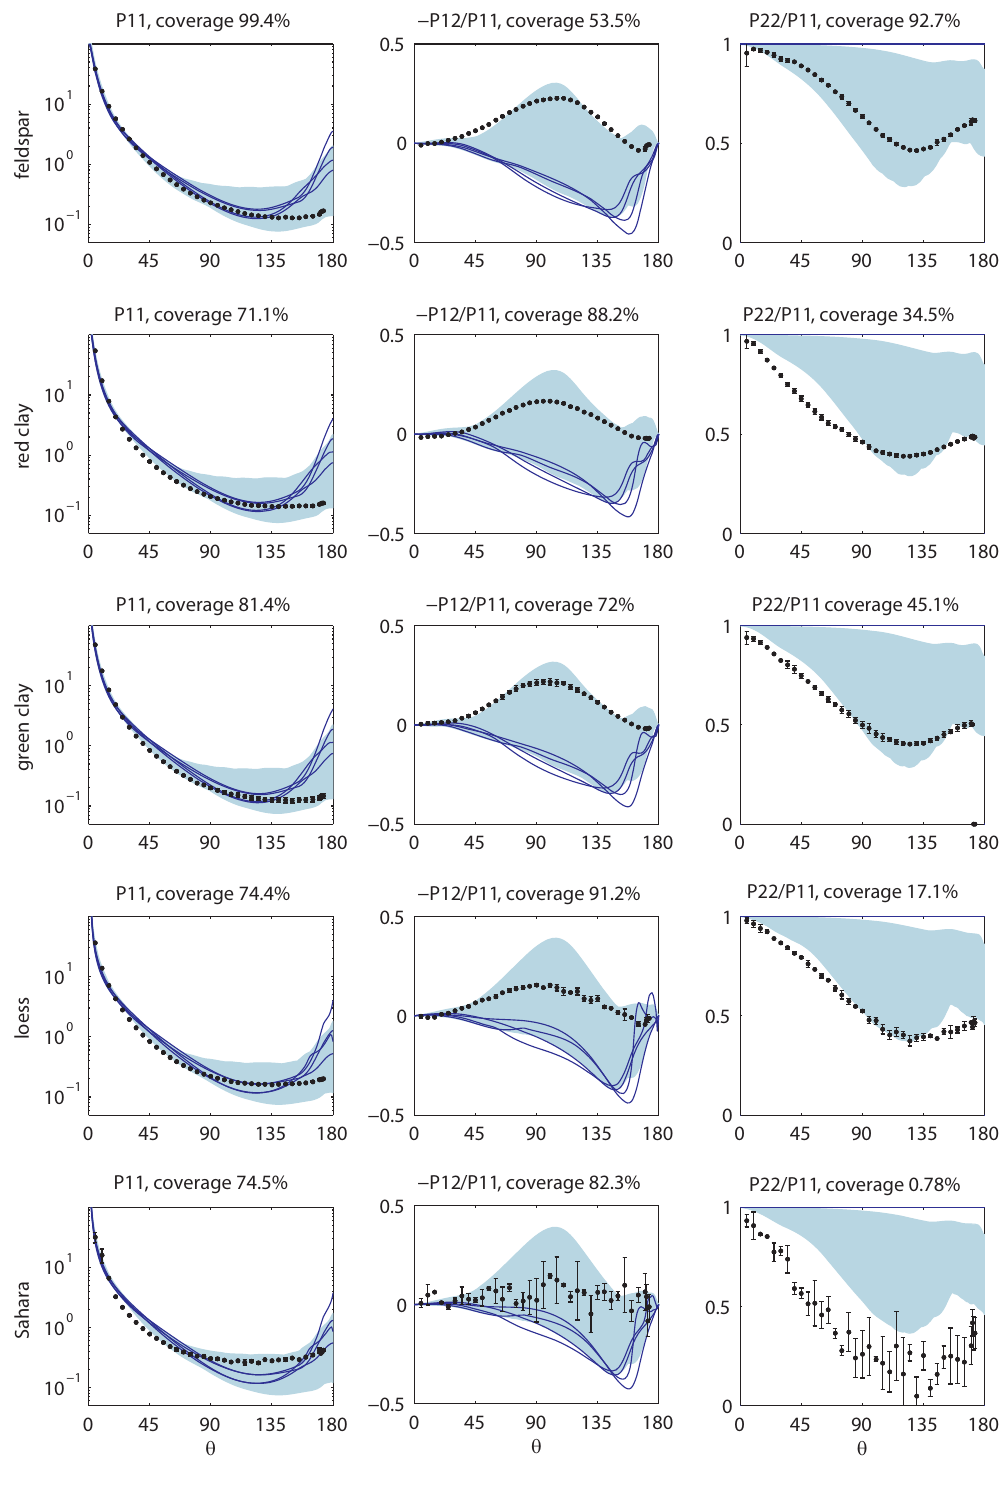
Fig. 2. Coverage of the measured scattering-matrix elements by model spheroids at 632 . 8nm wavelength for the matrix elements P 11 , − P 12 /P 11 and P 22 /P 11 . Each row corresponds to one sample from smallest (feldspar) to the largest effective radius (Sahara). Measurements are shown with diamonds and error bars, and the shaded area indicates the coverage by different spheroids (all shapes and refractive indices), excluding spheres. The Mie spheres are shown with solid lines for each refractive index. To normalise the measured P 11 element, it has been extrapolated with the n = 3 model shape distribution for the angles of 0 ◦ –5 ◦